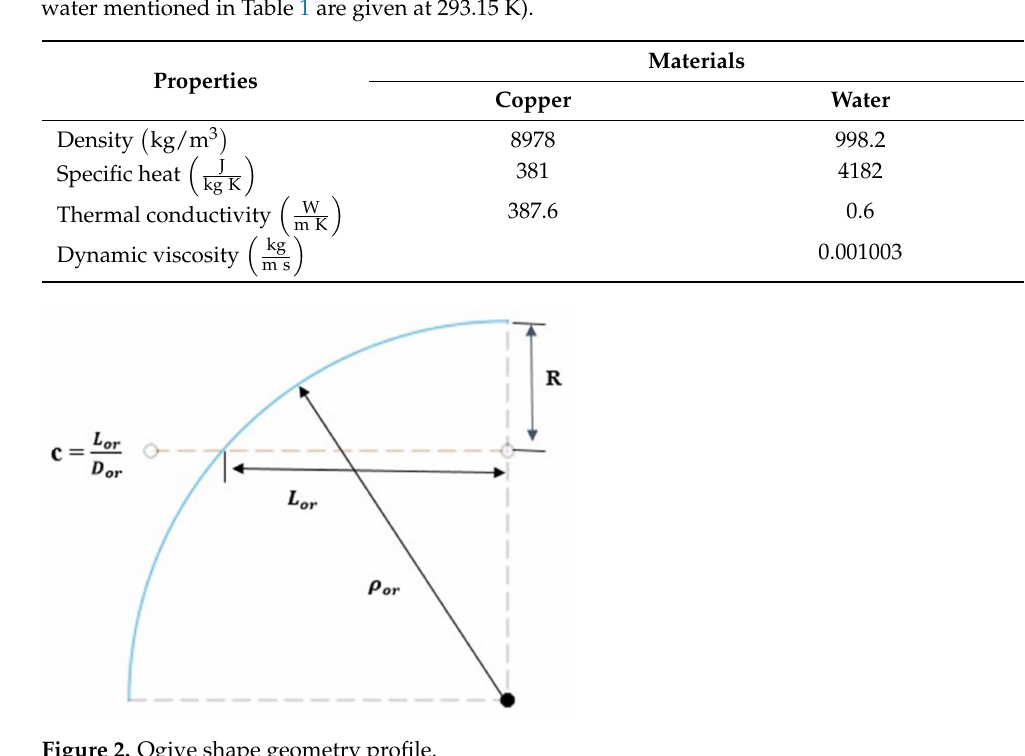
Figure 2. Ogive shape geometry